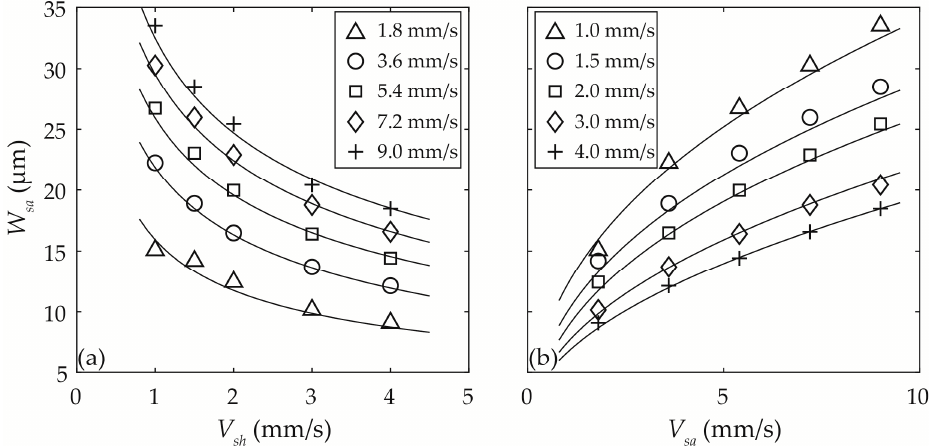
Figure 13. The width of sample particles stream W sa as a function of ( a ) sheath flow velocity V sh at five di ff erent sample flow velocities V sa , and ( b ) V sa at five di ff erent V sh . In this figure, the discrete points with di ff erent marker styles derive from the experimental measurement. Whereas, the solid curves derive from the theoretical simulation conducted in Section 3, which are the same as those shown in Figure 6.